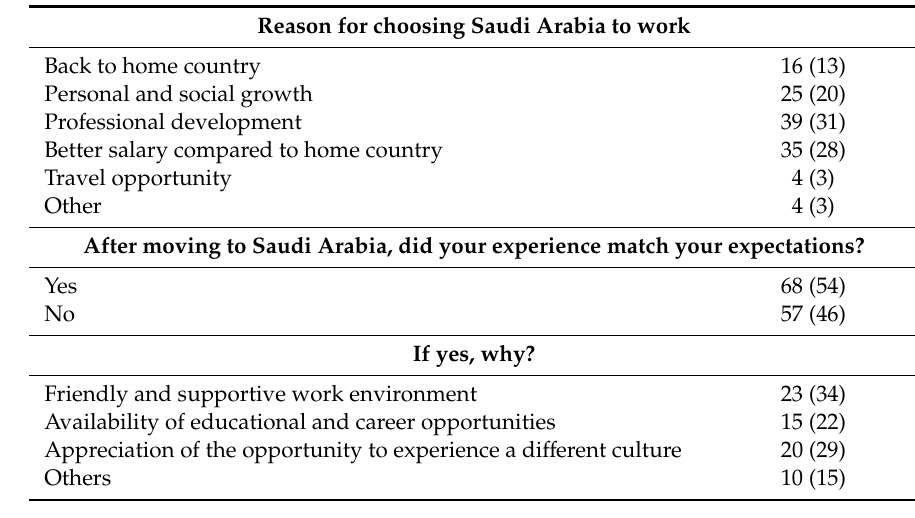
Table 3. Level of satisfaction among respondents regarding working outside their home country. Percentages are provided in